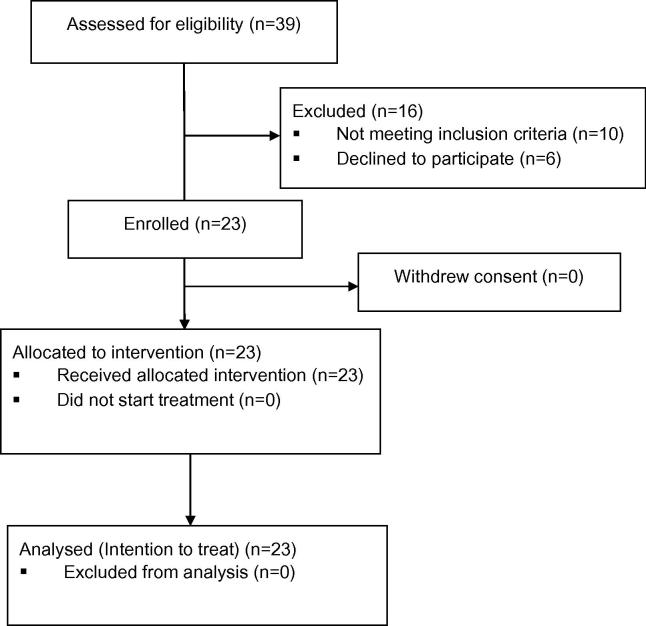
Consort diagram summarising the flow of patients.